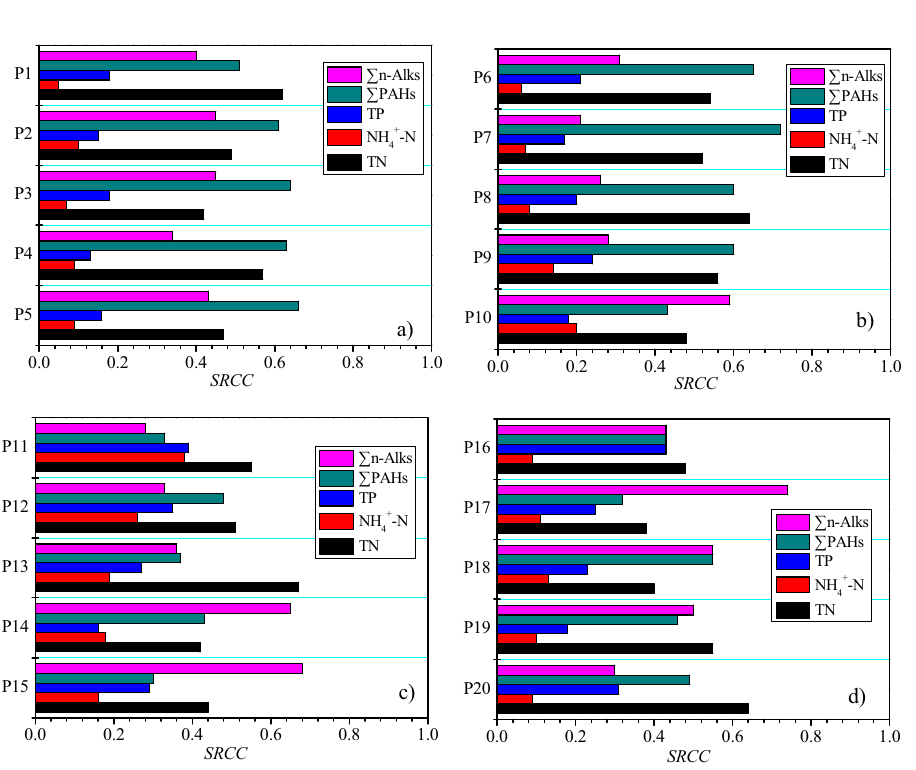
Figure 5. SRCC of the 5 evaluation indicators for the 20 monitoring sections in the East Tiaoxi River. ( a ) P1 ~ P5, ( b ) P6 ~ 10, ( c ) P11 ~ P15, ( d ) P16 ~